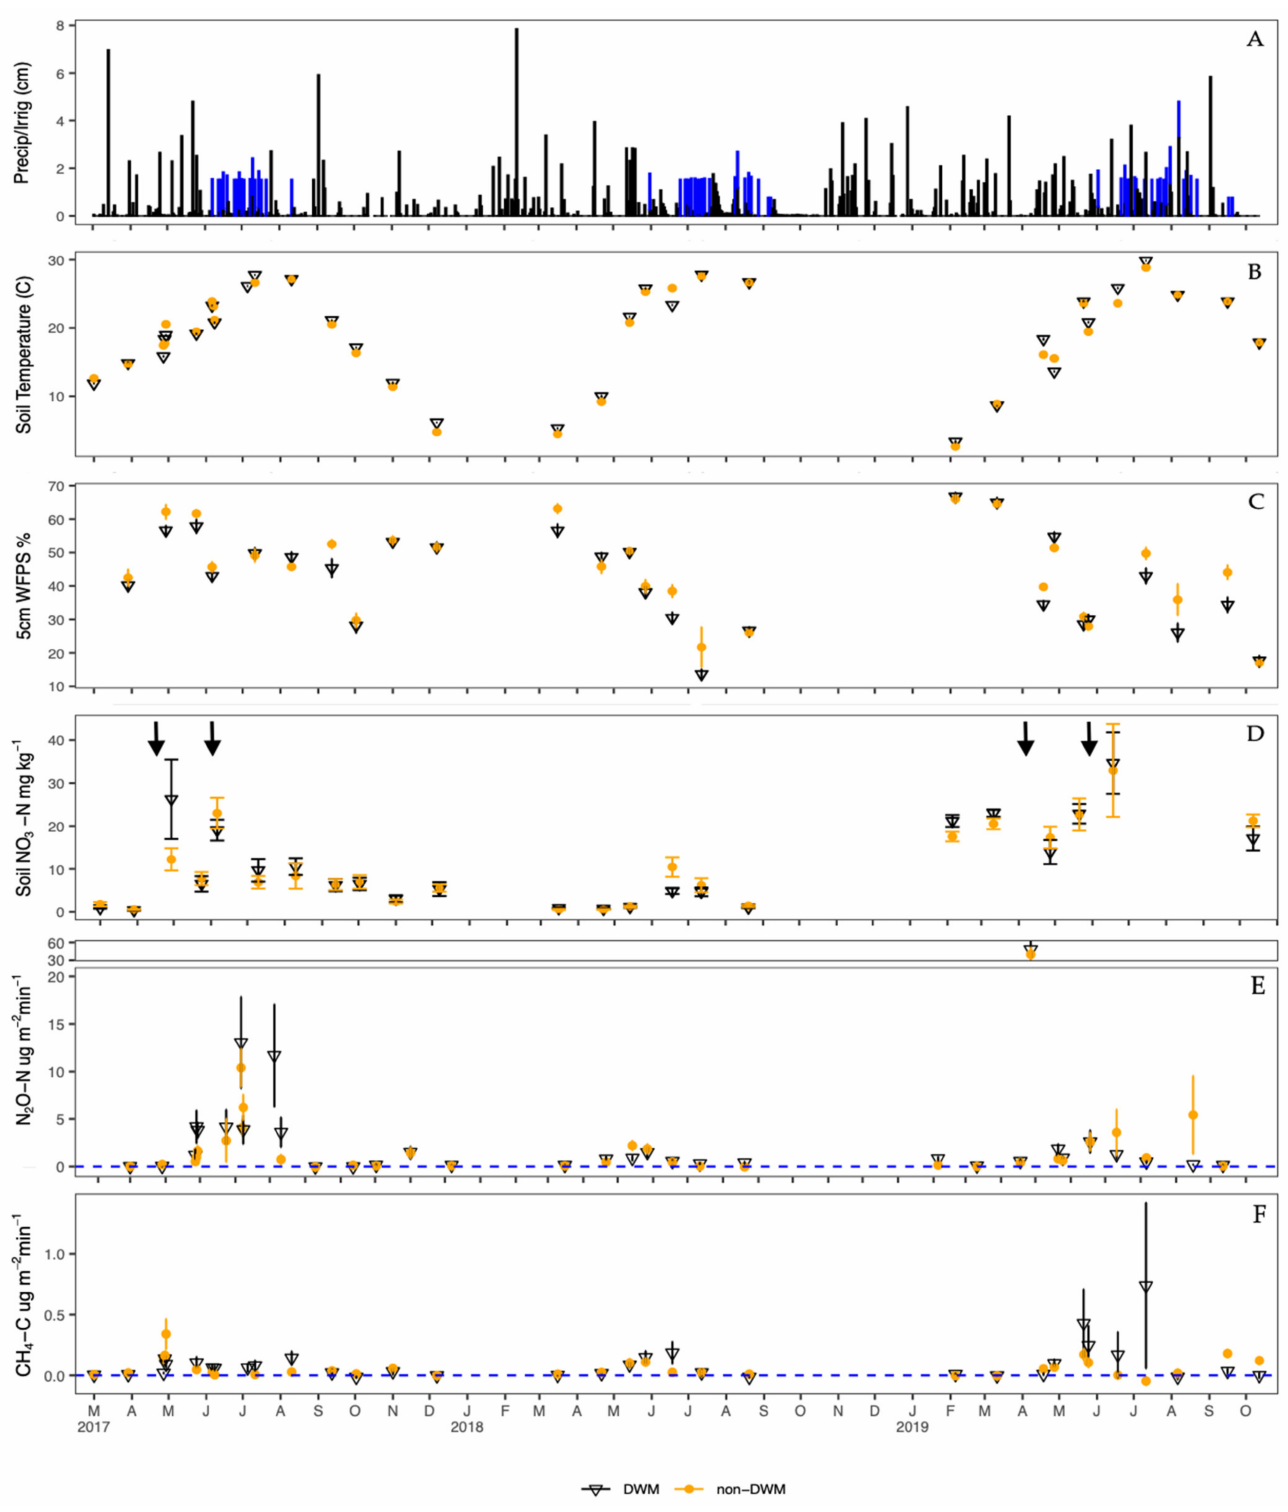
Figure 2. Climactic, soil, and flux variables measured over the course of this study. Arrows mark N fertilization events. Blue bars in panel ( A ) are irrigation events and black bars are precipitation events. The other measured variables are soil temperature ( B ), WFPS ( C ), soil nitrate ( D ), N 2 O-N flux ( E ) and CH 4 -C flux ( F ). Dashed blue lines in panels ( E , F ) mark the value of zero net flux. Mean + SE